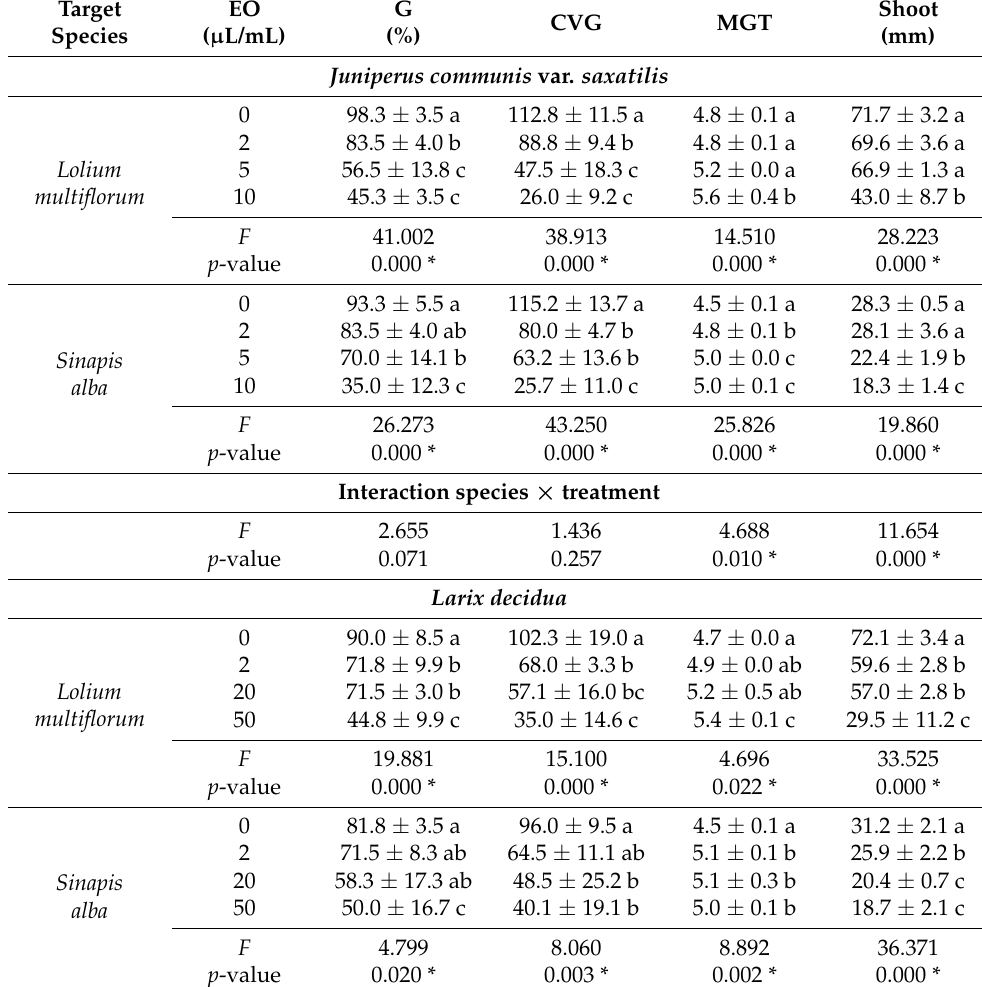
Table 9. Germination and growth values of two target species ( Lolium multiflorum and Sinapis alba ) under the phytotoxic effects of different doses of Juniperus communis var. saxatilis and Larix decidua EOs using soil as a